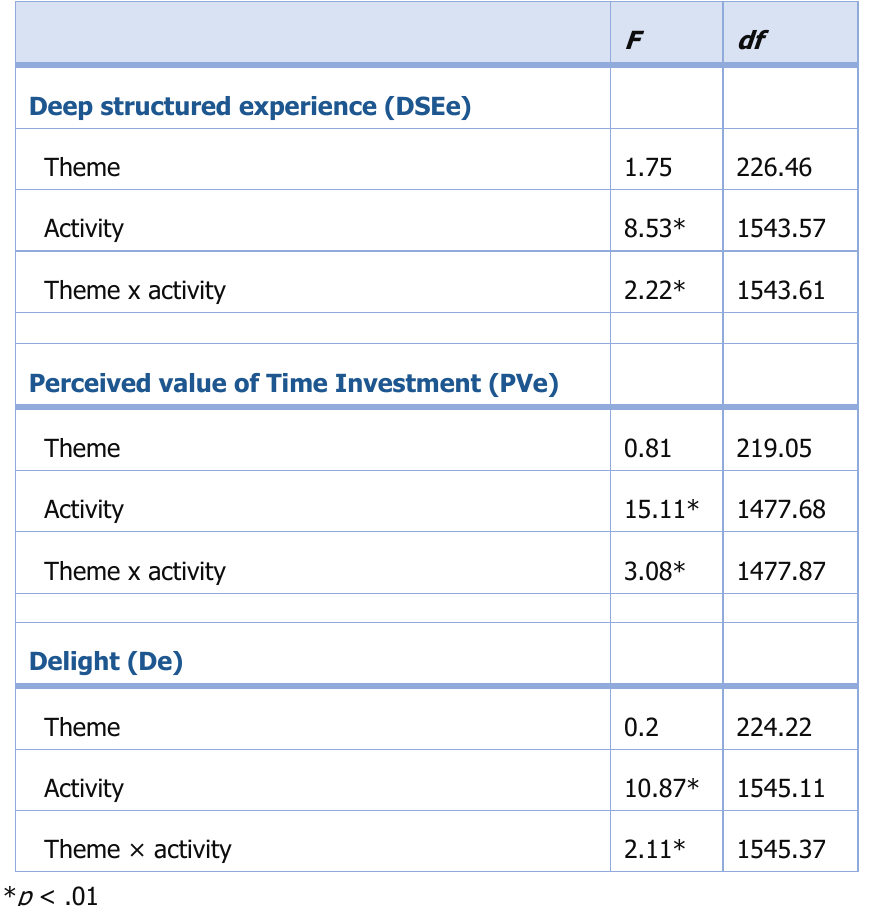
Table 2. Theme-by-Activity Interaction Effects on DSEe, PVe, and De